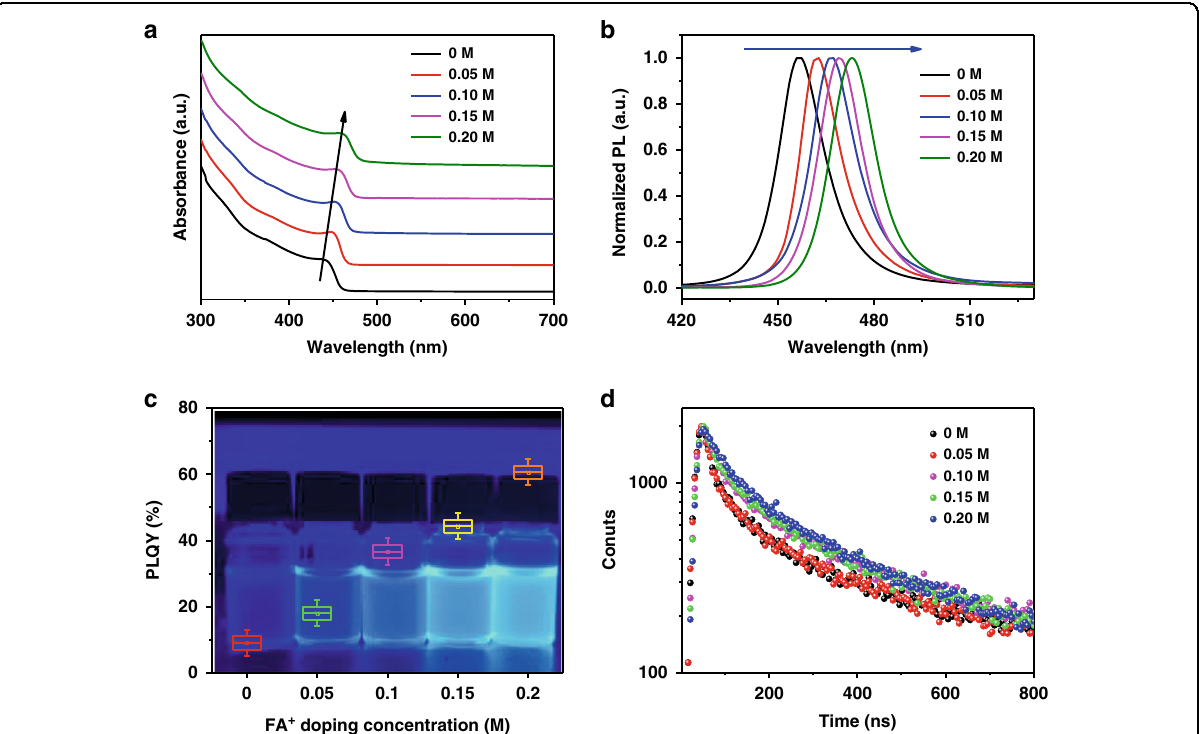
Fig. 2 Photophysical properties of all blue QDs. a absorption spectra, b photoluminance spectra, c PLQY, d TRPL decay curves of FA + doped CsPb(Cl 0.5 Br 0.5 ) 3 QDs with FA + feeding ratio of 0, 0.05, 0.1, 0.15, and 0.2 M, respectively. The background inset of ( c ) shows the picture of the QDs under a UV lamp illumination with 365